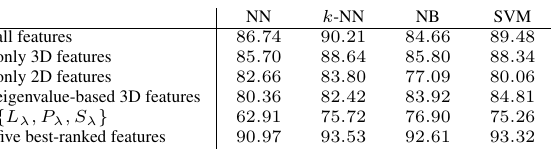
Table 3: Overall classification accuracies in % for different fea- ture subsets and different classifiers. 4 DISCUSSION